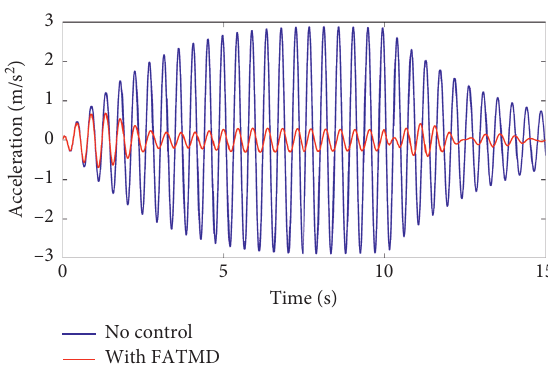
Figure 13: The acceleration time history in the midspan of the bridge ( f